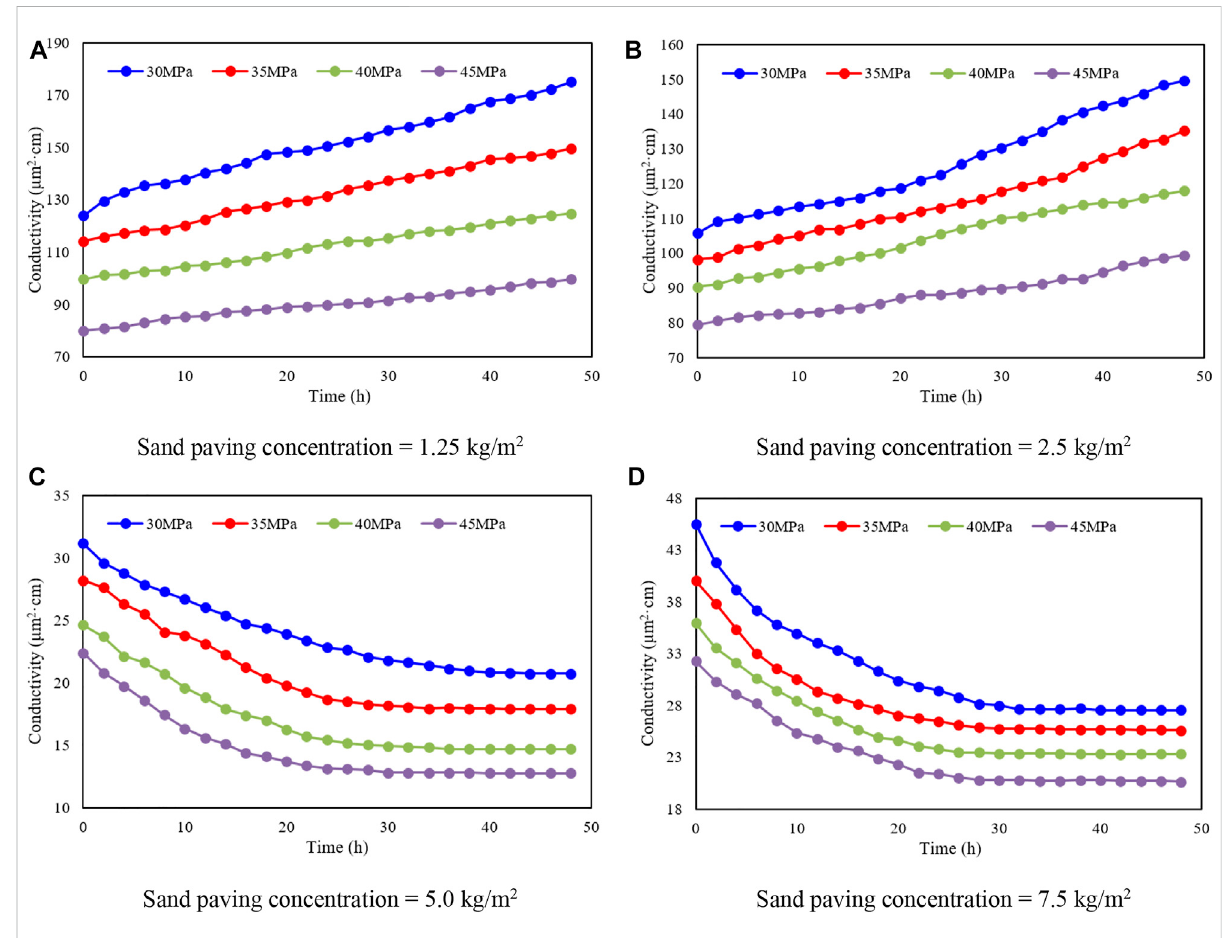
FIGURE 9 The proppant conductivity of CF 20 – 40 at different sand paving concentrations and different closure pressures.